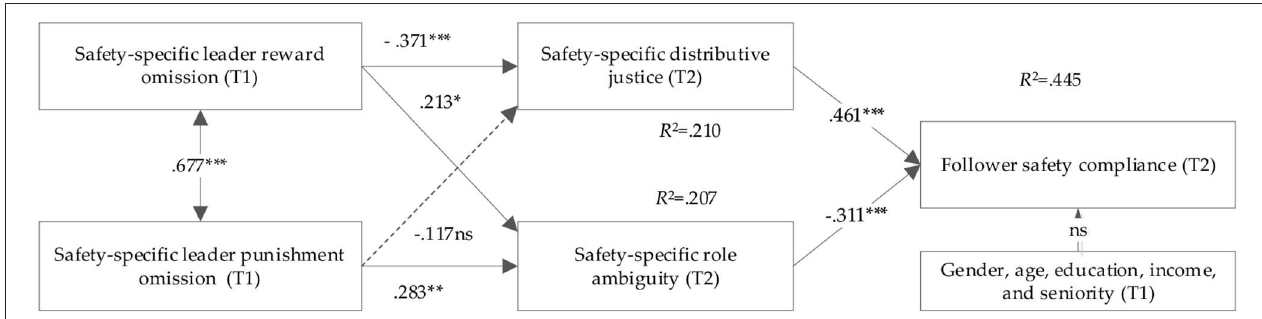
FIGURE 2 | Hypothesized model results. *** p < 0.001, ** p < 0.01, * p < 0.05, Not significant, p > 0.10. T1 and T2 represent the first and second wave data collection, respectively.